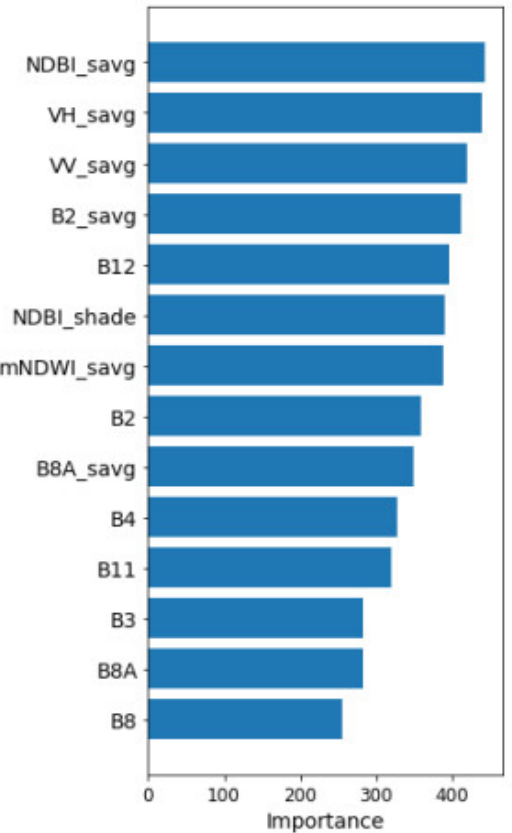
Table 6. Accuracy of different classification schemes.